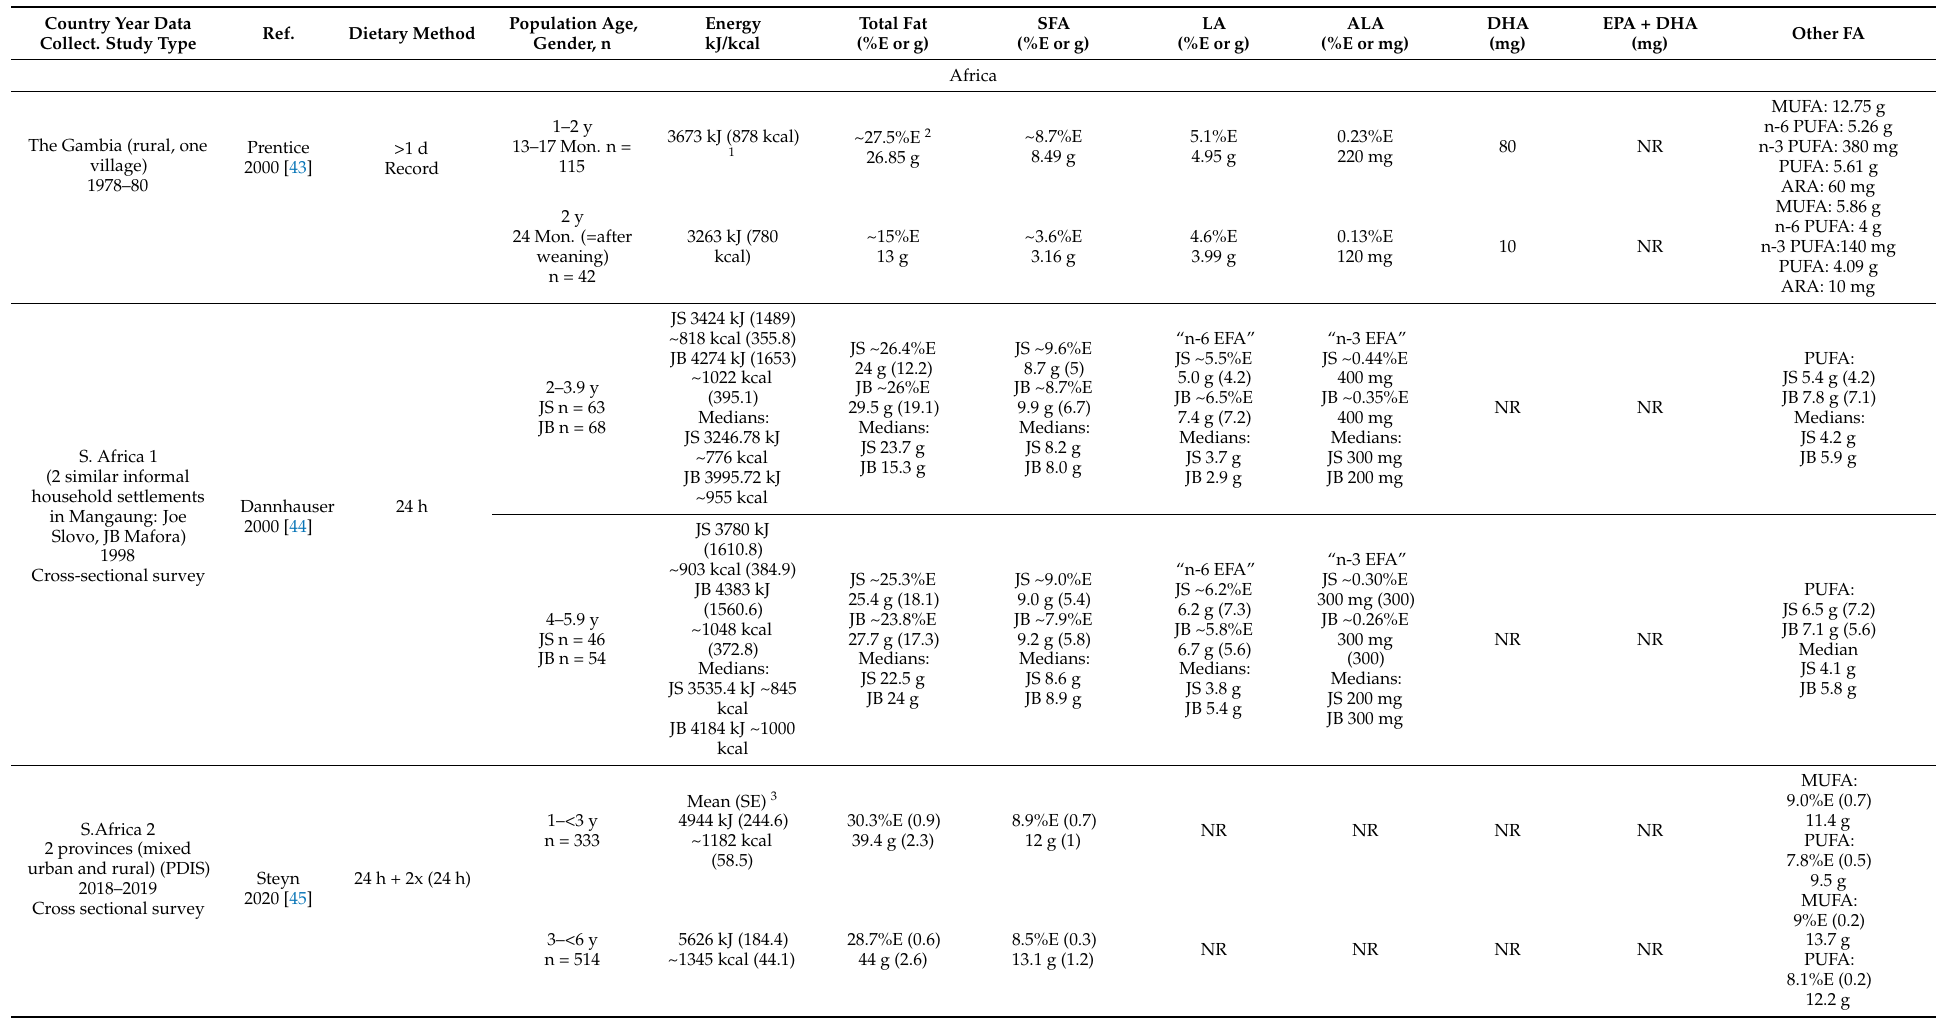
Table 2. Observed daily energy, total fat and specific fatty acids intake in 1–7 years old children [means (SD), when not specified, or median